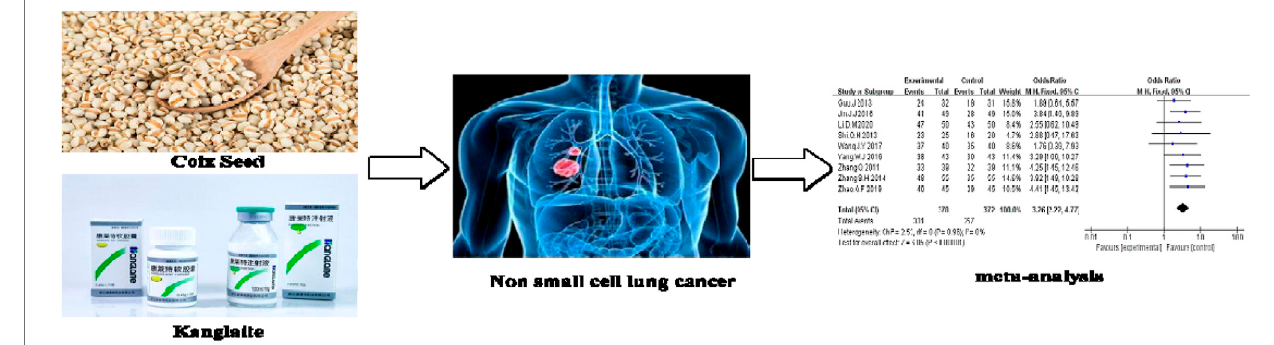
FIGURE 1 | Work fl ow of the present